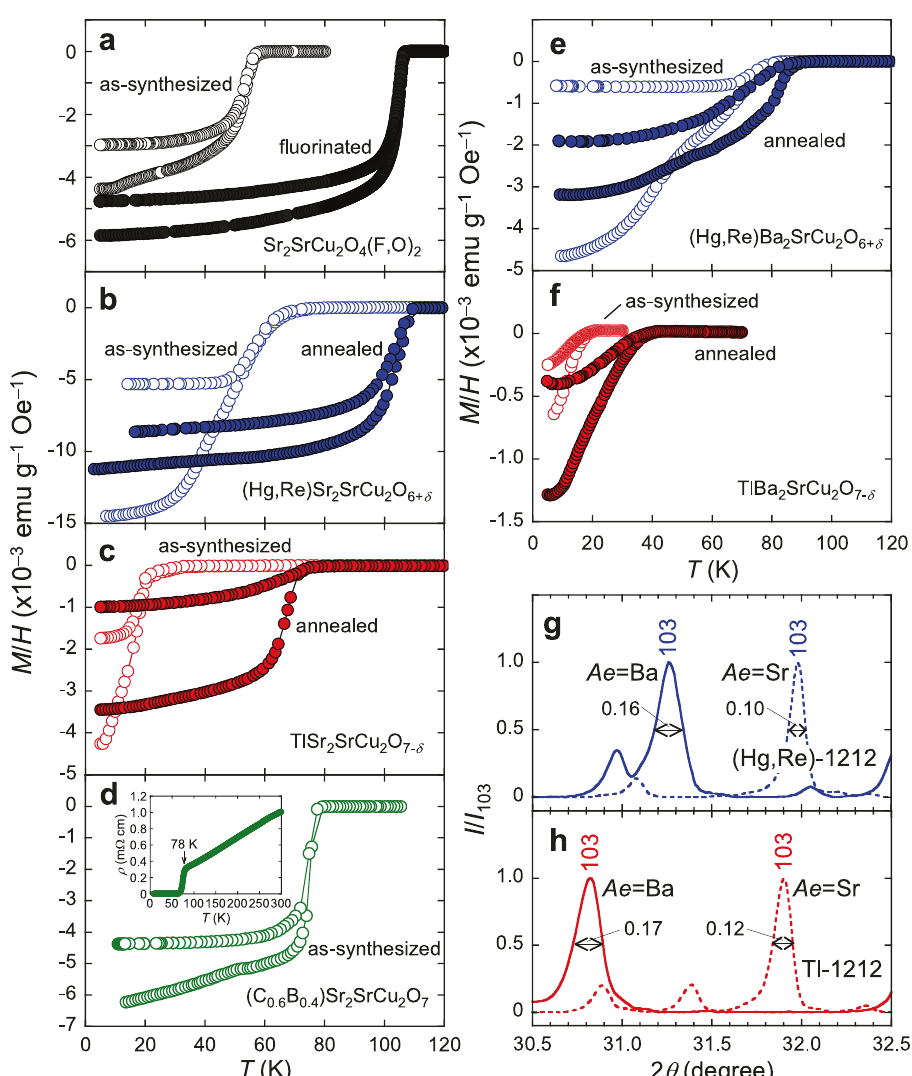
Fig. 2 Superconductivity in Ca-free double-layered cuprates. a – d Temperature ( T ) dependence of the magnetic susceptibility ( M / H ) of a 0212-F, b (Hg,Re)-1212, c Tl-1212, and d (B,C)-1212 samples with Ae ¼ Ae 0 ¼ Sr, measured under H = 10 Oe. For (B,C)-1212, the zero- fi eld electrical resistivity ( ρ ) as a function of temperature is presented in the inset of d . e , f M / H vs. T data for e (Hg,Re)-1212 and f Tl-1212 with Ae = Ba and Ae 0 ¼ Sr. The open (closed) circle indicates the data for the as-synthesized ( fl uorinated or annealed) sample. For all the susceptibility curves, the lower and upper parts of the data branching to lower T corresponds to zero- fi eld cooling (ZFC) and fi eld cooling (FC), respectively. g , h Enlarged view near the highest peak in the XRD patterns of the Ca-free g (Hg,Re)-1212 and h Tl-1212 for Ae = Sr (dashed line) and Ba (solid line). Each datum is normalized to the (103) peak intensity. The double arrow indicates the FWHM of the (103)